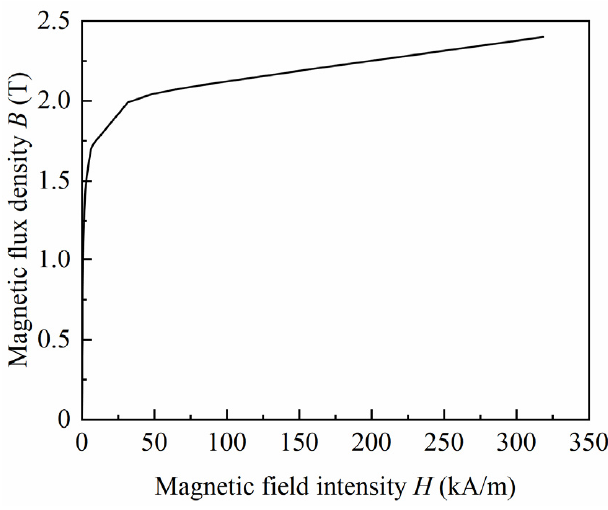
Figure 3. Magnetization curve of No. 10